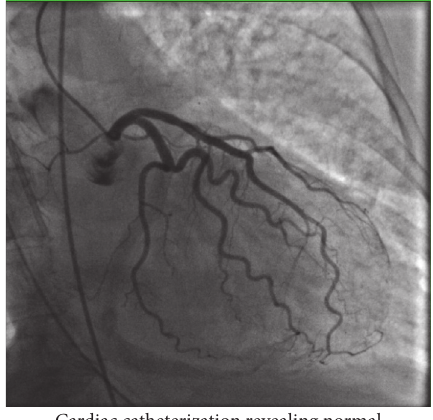
Figure 2: Left coronary artery.